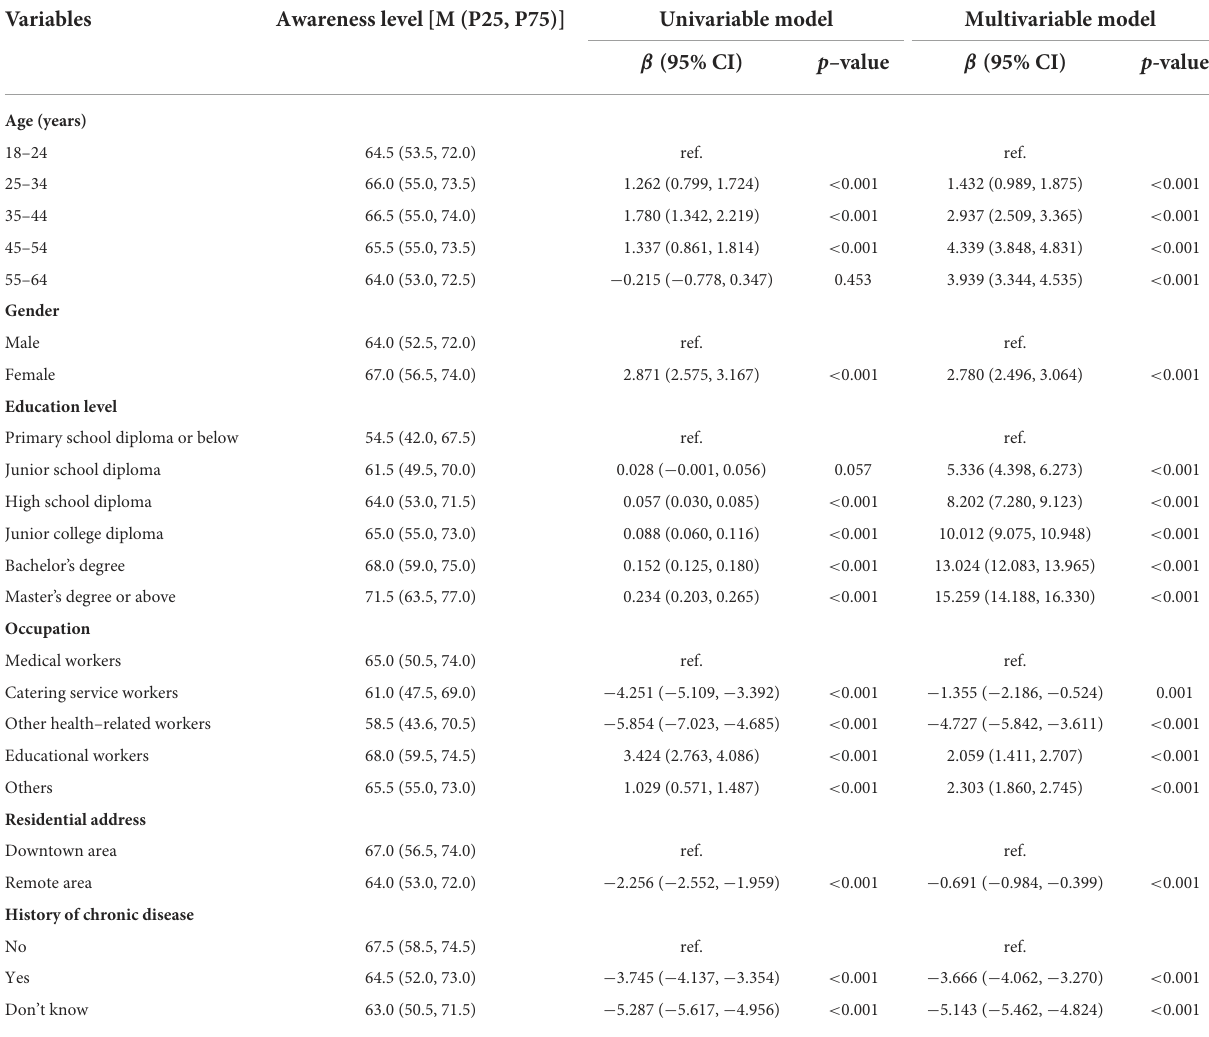
TABLE 4 Factors influencing the awareness level of nutrition and health knowledge *